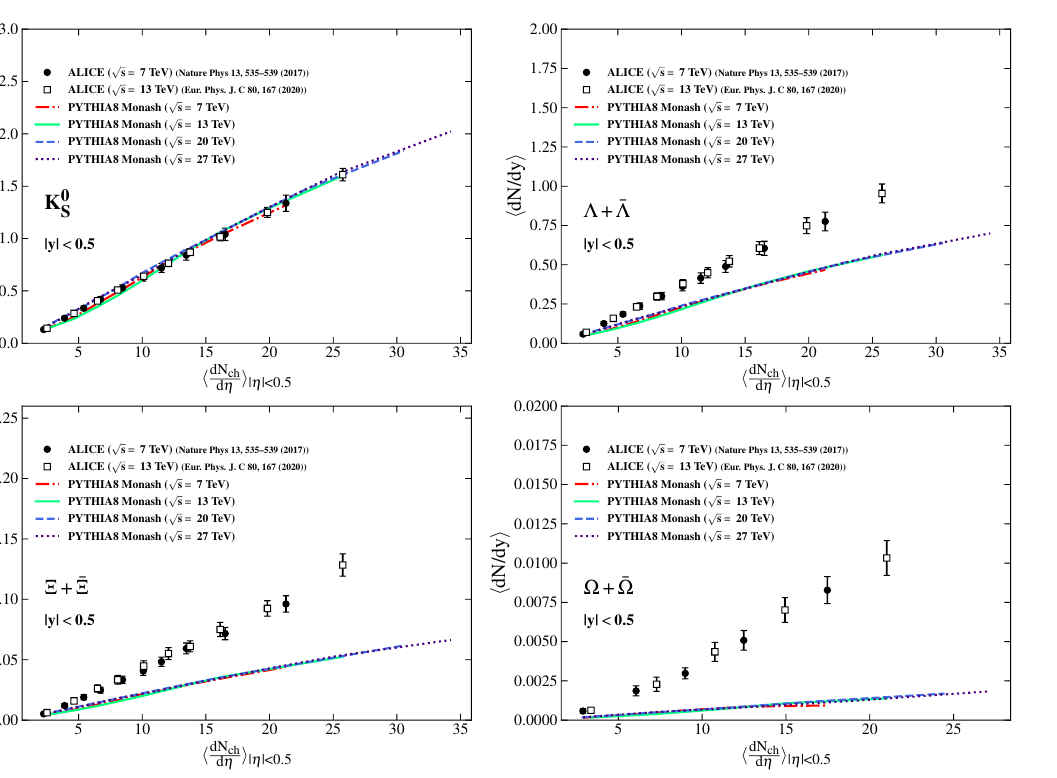
Figure 10. Integrated yields of K 0 at √ s = 7 TeV, 13 TeV, 20 TeV, and 27 TeV using PYTHIA8 (Monash tune)